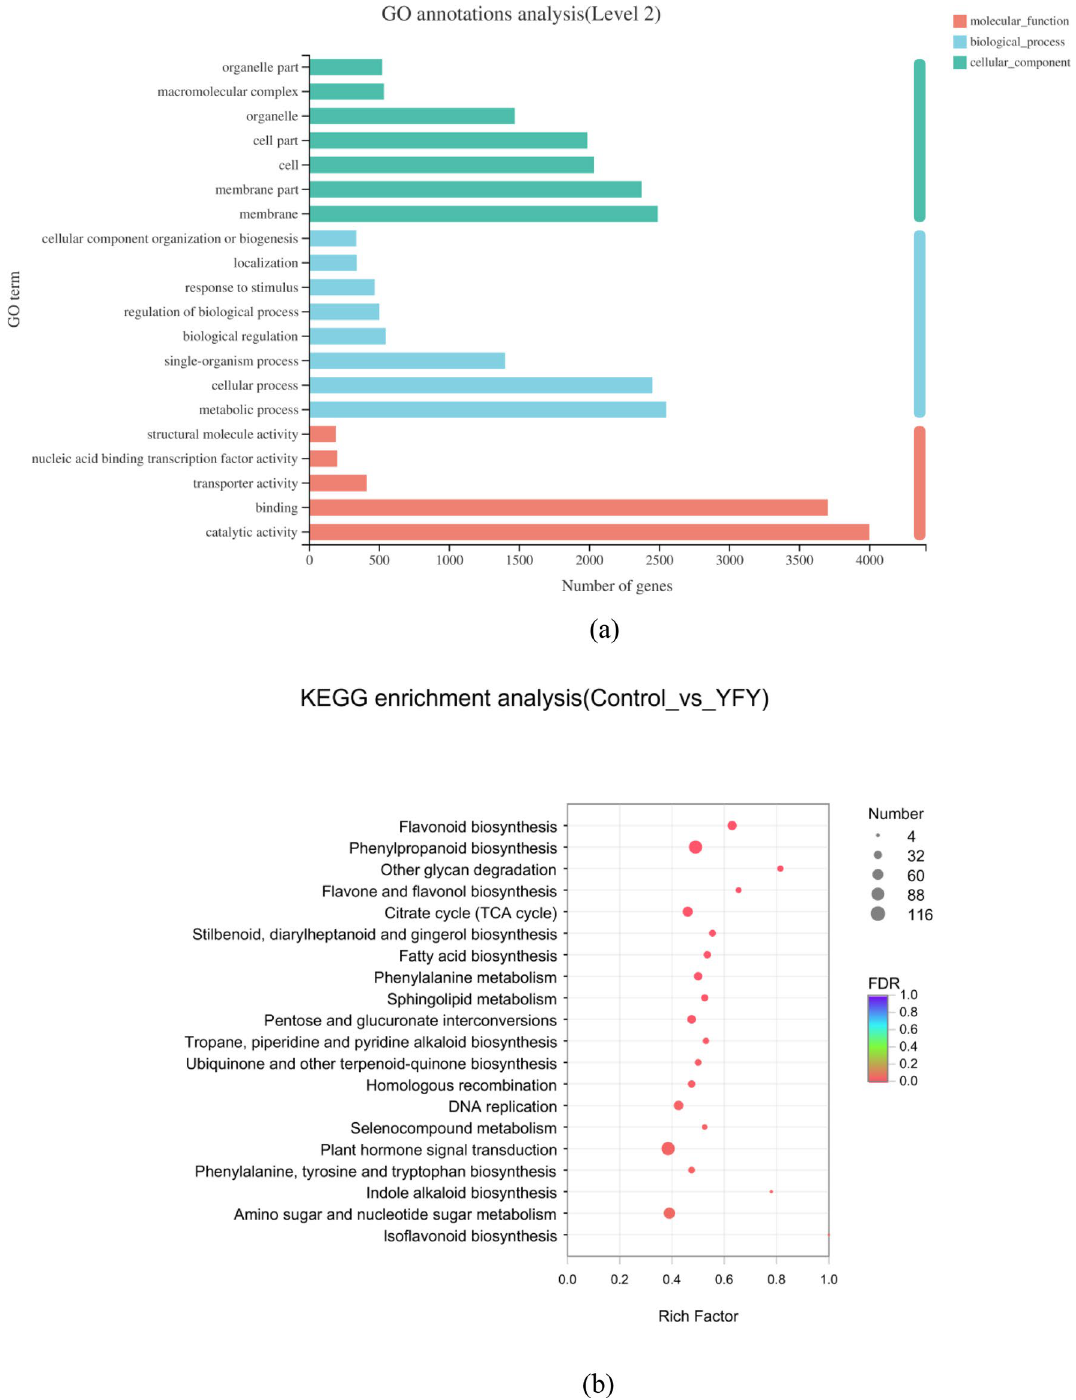
Figure 3. ( a ) GO terms enrichment of differentially expressed transcripts. The ordinate represents the secondary classification of GO, while the abscissa represents the number of genes included in the secondary classification. The color bars on the right represent the three branches of GO (blue, biological process; green, cellular component; dark pink: molecular function). ( b ) Statistics for the top 20 enriched pathway terms in the comparison of YFY vs control. The vertical axis represents the pathway name, and the abscissa represents the rich factor (i.e., the ratio of DEGs annotated in this pathway term to all gene numbers annotated in this pathway term; a greater rich factor indicates greater intensiveness). The size of the point indicates the number of genes in the pathway, while the color of the point corresponds to the Q value